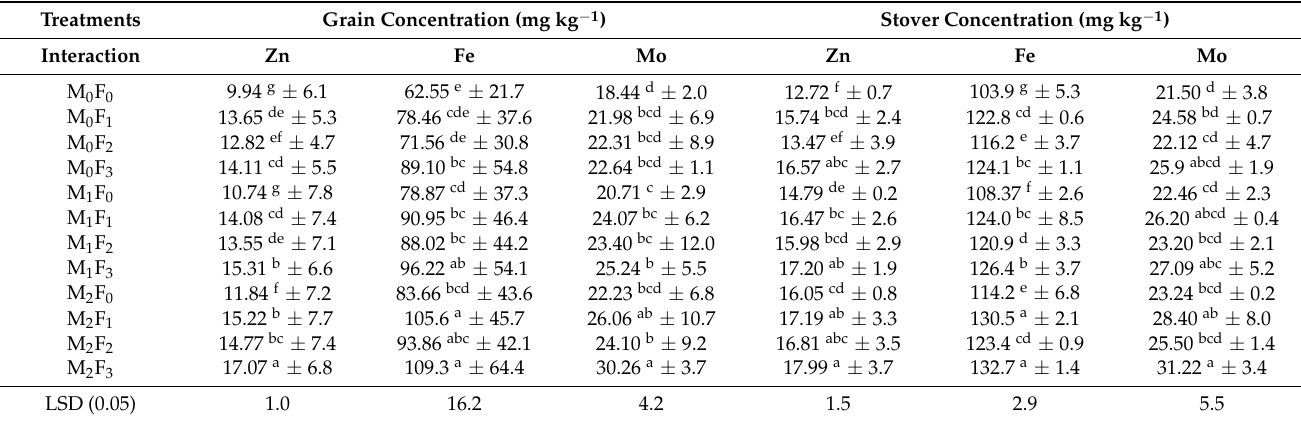
Table 3. Effect of the application of Zn, Fe and Mo molecule on the concentration of micronutrients in the grain and stover of cowpea.